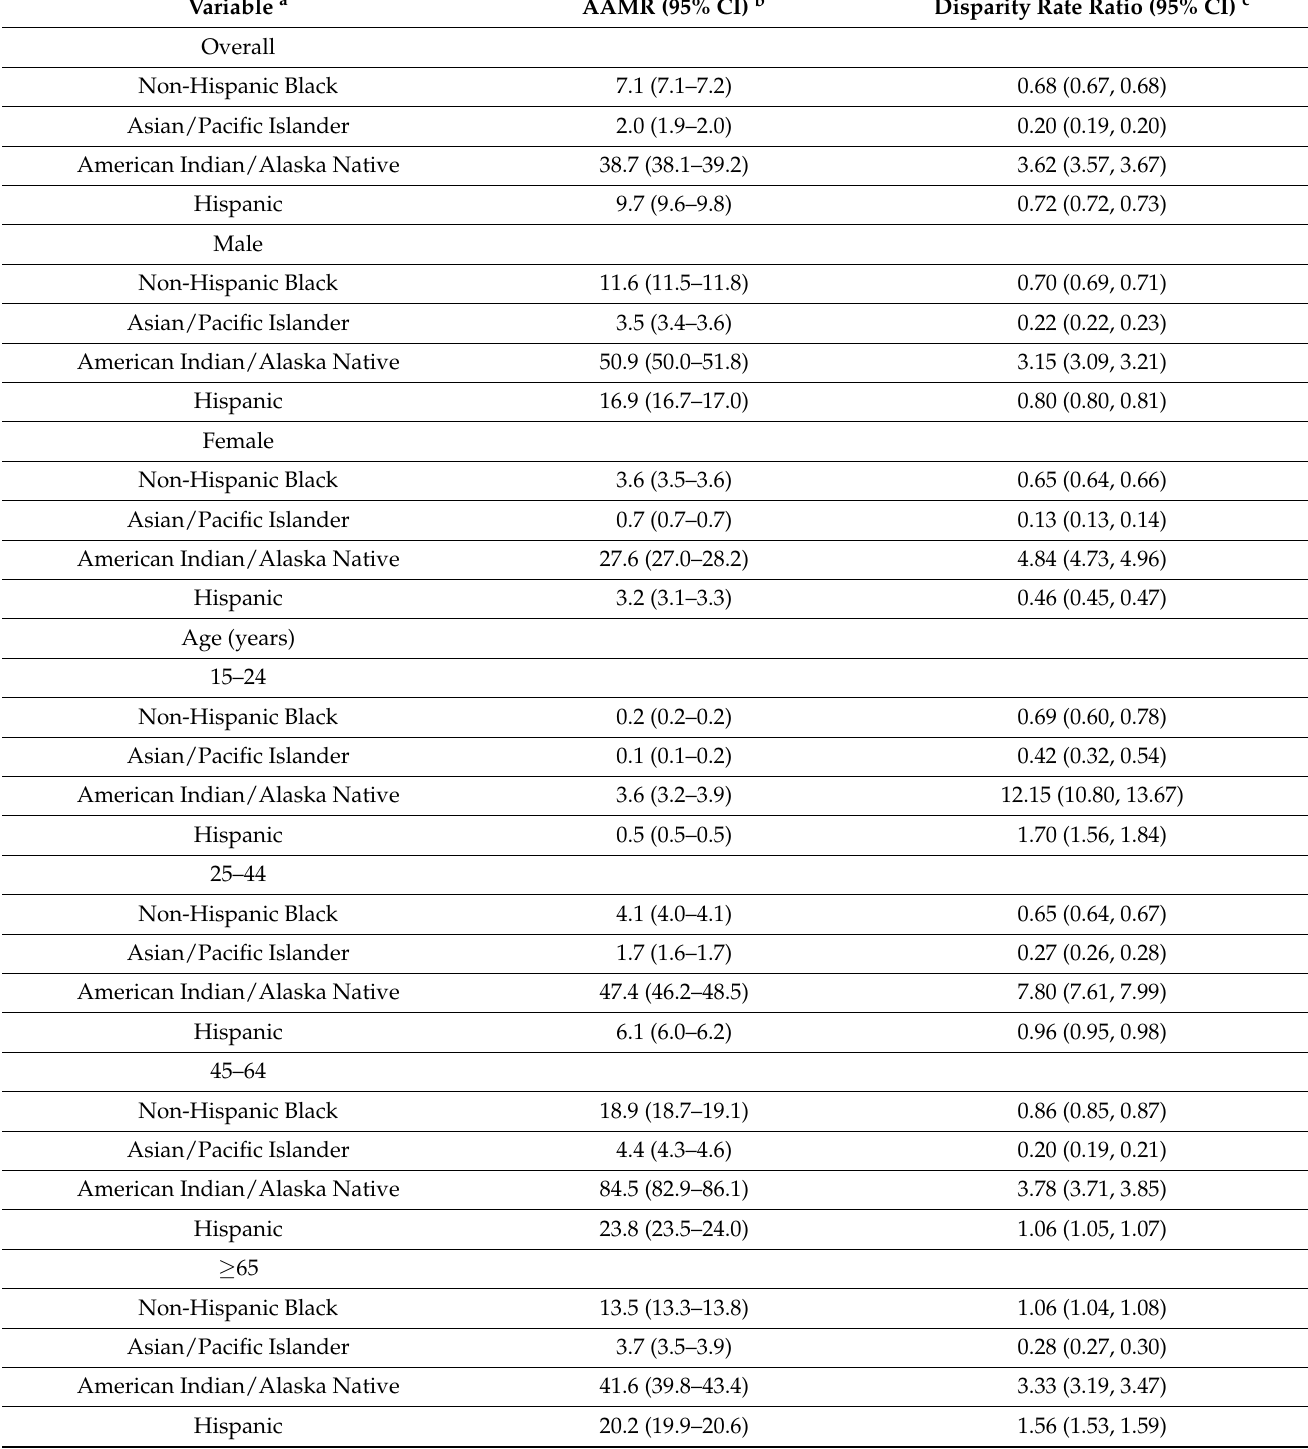
Table 1. Racial/Ethnic Disparities in Alcohol Mortality Rates in the United States by Sex, Age,